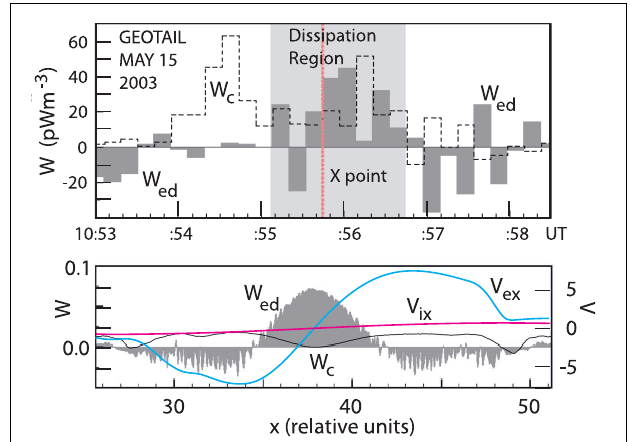
FIGURE 9 | Determination of the energy dissipated in the magnetospheric tail current sheet during ongoing reconnection from observations of Geotail (observations and simulation data taken from Zenitani et al. [156] courtesy of American Geophysical Union). Top: Geotail data of electron energy W vs. universal time UT. The gray histogram is the dissipated electron energy W ed determined from the measurements. W c is the convection energy. The vertical red line shows the time of crossing the location of the X point as estimated from the magnetic and plasma profiles when passing the current sheet. The electron dissipation region is indicated by gray shading. The dotted histogram shows for comparison the convective energy term in Ohm’s law. Bottom: Accompanying particle-in-cell simulations for the observational conditions. Shown are the mean electron (blue) and ion (red) velocities as well as the simulated dissipated and convection energies W ed (gray shading) and W c (almost unaffected black curve) along a cut through the X point in the center of the current sheet. The dissipated energy is positive in the dissipation region, where it maximizes thus indicating electron heating/acceleration. Acceleration of electrons into formation of two quasi-symmetric electron jets in opposite x -directions is indicated by the blue curve. Note that the electron jets extend substantially out from the dissipation region until becoming braked and assuming the same speed as the ions. Here the quasineutral plasma jets are born. Weak braking starts already soon after the electron jets have left the dissipation region indicating interaction with the ion fluid already here. Energy transfer from electrons to ions is indicated by negative dissipation energies W ed . Since no effect is seen in the ion bulk flow the dissipated electron jet energy goes into ion